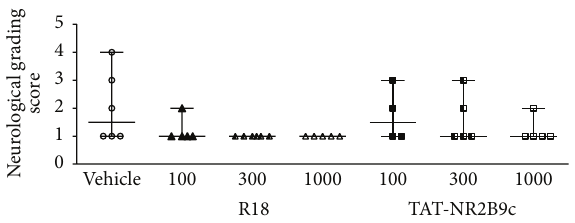
Figure 2: Neurological grading scores 24 hours after permanent MCAO (0 = no deficit, 5 = major deficit) for saline (vehicle) and peptide (R18 and TAT-NR2B9c at 100, 300, or 1000 nmol/kg) treatment groups. Lines on graph indicate range and median for neurological